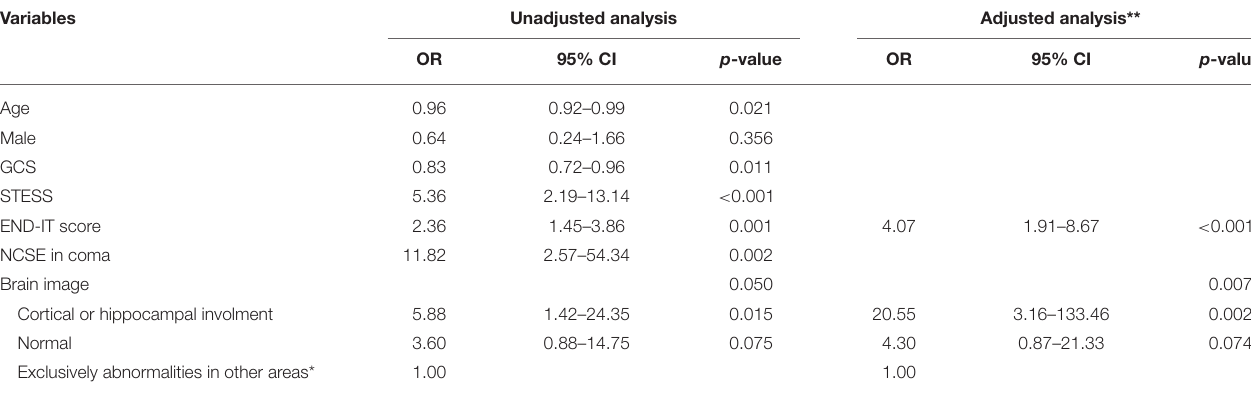
TABLE 2 | Logistic regression analysis for predictors of SRSE in acute